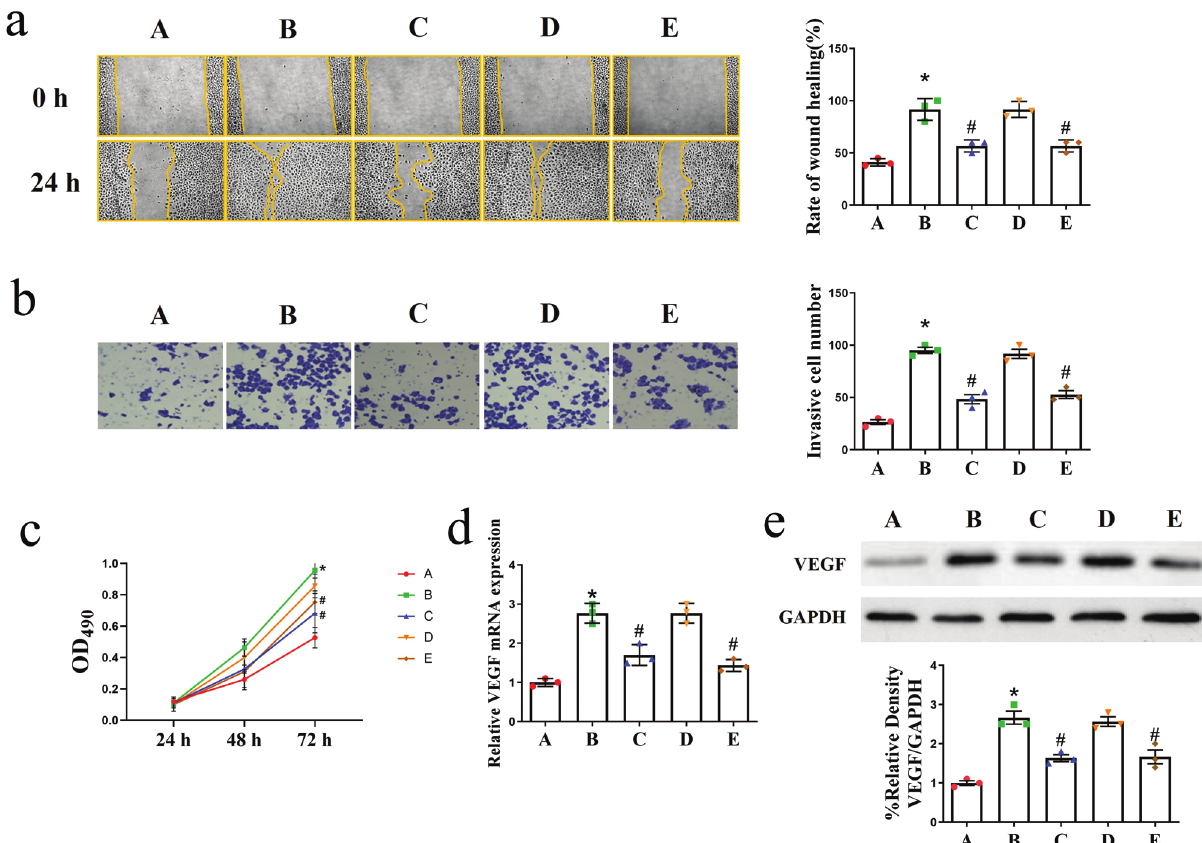
Fig. 4. Effect of enhanced OCR in EpCAM + CD44 + cells on cell migration, cell proliferation and the expression of VEGF. (a) Cell migration in each group, as assessed by wound-healing assay. (b) Cell migration in each group, as assessed by Transwell migration assay. (c) Cell proliferation in each group, as assessed by MTT assay through the OD at 490 nm. (d, e) mRNA and protein expression of VEGF in each group. A: Con; B: EpCAM + CD44 + ; C: EpCAM + CD44 + + phenformin; D: EpCAM + CD44 + + siRNA-NC; E: EpCAM + CD44 + + siRNA-NDFUB8. Results are expressed as mean ± SD ( n = 3). * P < 0.05 versus A group. # P < 0.05 versus B